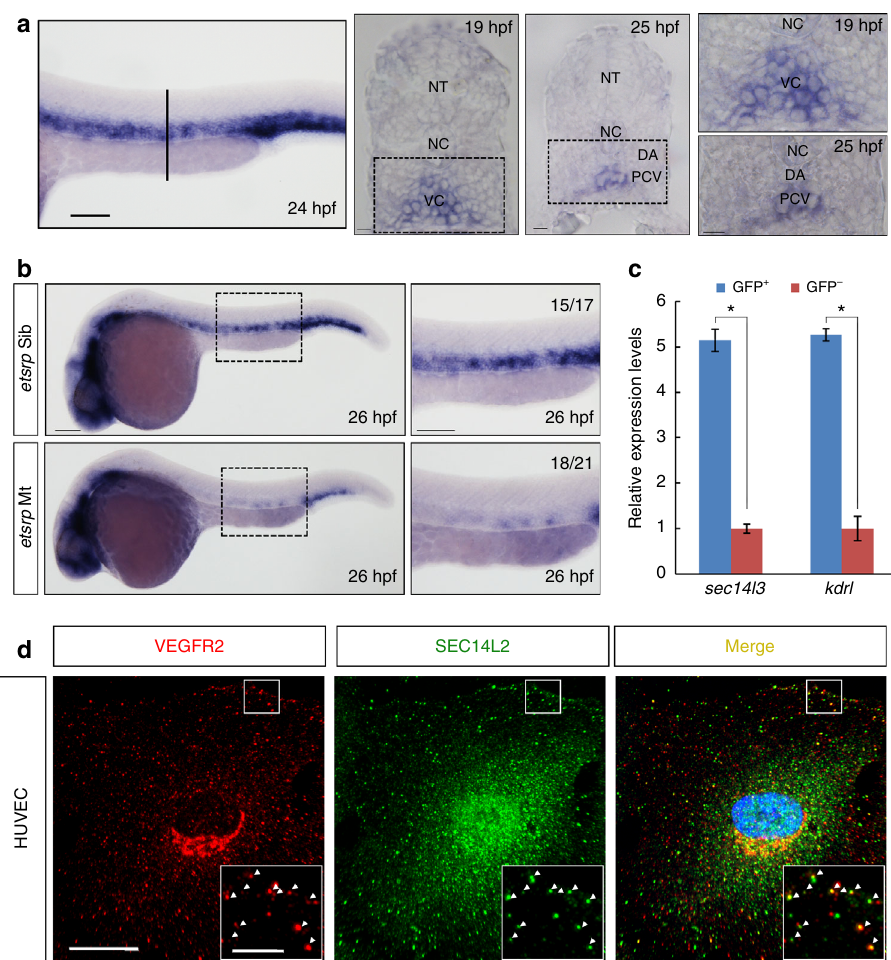
Fig. 1 sec14l3/SEC14L2 are expressed in endothelial cells and co-localized with VEGFR2. a Expression pattern of sec14l3 examined by WISH. Trunk vascular expression of sec14l3 is shown at 24 hpf and the vertical line denotes the equivalent position of transverse sections in embryos at 19 hpf and 25 hpf. High- resolution views of the boxed regions are shown at right panels. Adjacent tissues are denoted. NT, neural tube; NC, notochord; DA, dorsal aorta; PCV, posterior cardinal vein; VC, vascular cord. Scale bars, 100 μ m. b The absence of sec14l3 expression in the trunk vascular system of etsrp mutant embryos at 26 hpf. High-resolution views of the boxed regions are shown at right panels. Scale bars, 100 μ m. c Quantitative RT-PCR of sec14l3 mRNA in both GFP + cells and GFP - cells from Tg( fl i1a:EGFP) y1 transgenic embryos at 24 hpf. sec14l3 is highly enriched in GFP + cells (blue bars) relative to negative cells (red bars), using β -actin as the internal control. kdrl/vegfr2 mRNA serves as a positive control for vascular endothelial cells. A two-tailed t -test was used for statistical analysis. * p < 0.05, the exact p-values in each fi gure are shown in the Source data fi le. d SEC14L2 is co-localized with VEGFR2 in HUVECs. Red and green represent anti-VEGFR2 antibody and anti-SEC14L2 antibody staining signal respectively; blue symbolizes DAPI stained nucleus. Regions in the boxes are enlarged in the right corner. Scale bars, 20 μ m in the original pictures and 5 μ m in the enlarged